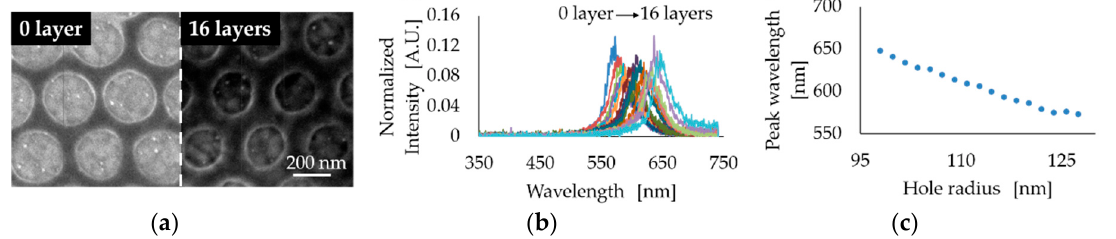
Figure 7. Evaluation of the three-defect, polymer-based PhC resonator and waveguide by the layer-by-layer (LbL) method. ( a ) FE-SEM images before and after LbL deposition, ( b ) Resonant spectral changes during the LbL process, ( c ) Relationship between PhC hole size and resonant wavelength.